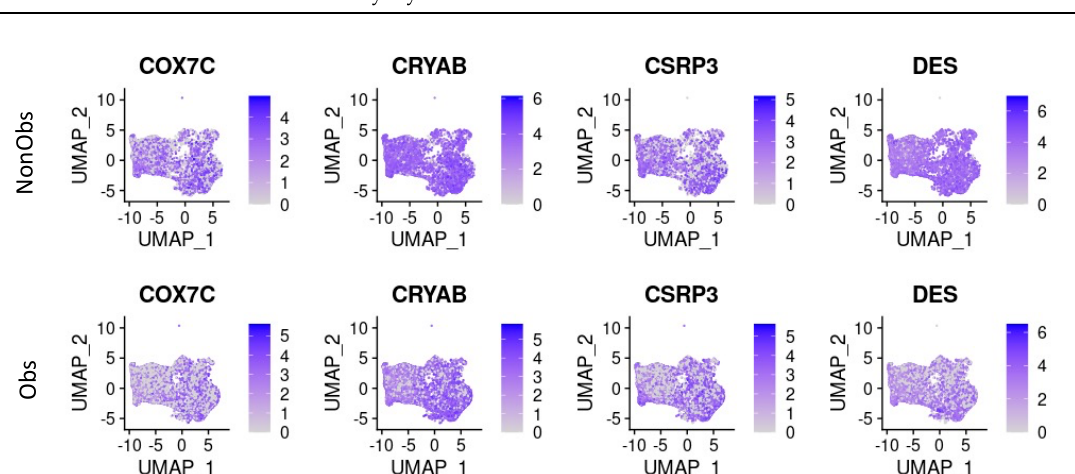
Figure 2. Differential expression of four representative cardiomyocyte genes in UMAP space from Table 1, revealing increased expression in nonobstructive HCM